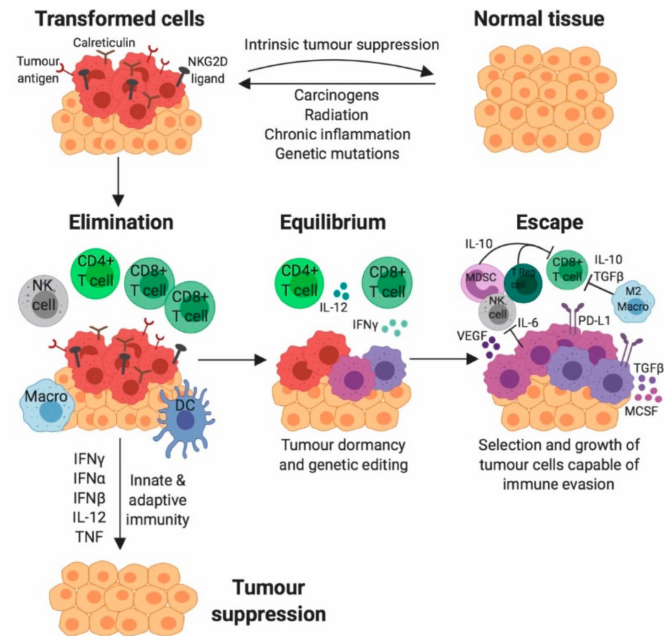
Figure 2. The three phases of cancer immunoediting. Normal cells transition to tumour cells expressing specific tumour antigens, calreticulin, and NKG2D ligands if subject to oncogenic mutational transformation. Elimination is the first phase of cancer immunoediting, where the cells of the innate and adaptive immune system are recruited to the site of the tumour antigens and attempt to destroy tumour cells via immune attack mechanisms (including secretion of cytokines IFN γ , IFN α , IFN β , IL-12 and TNF). Any persisting tumour cells enter the second phase, equilibrium, where selection pressures instigate new tumour cell genetic variants. These genetic modifications allow tumour evasion of the immune system and promotion to the third phase, escape, where tumour cells progressively develop and become clinically detectable as a palpable mass. Immune evasion is influenced by factors including tumour cell PD-L1 upregulation, secretion of immuno-inhibitory cytokines (IL-6, IL-10, TGF β and MCSF) and recruitment of inhibitory immune cells (M2 macrophages, Regulatory T (TReg) cells and Myeloid-derived suppressor cells (MDSCs)) that abrogate immune-mediated tumour cell killing via inhibition of Natural Killer (NK) cells and CD8 + T cells. Tumour cells also experience a downregulation of tumour antigen, calreticulin and NKG2D ligands, so are less susceptible to immune recognition